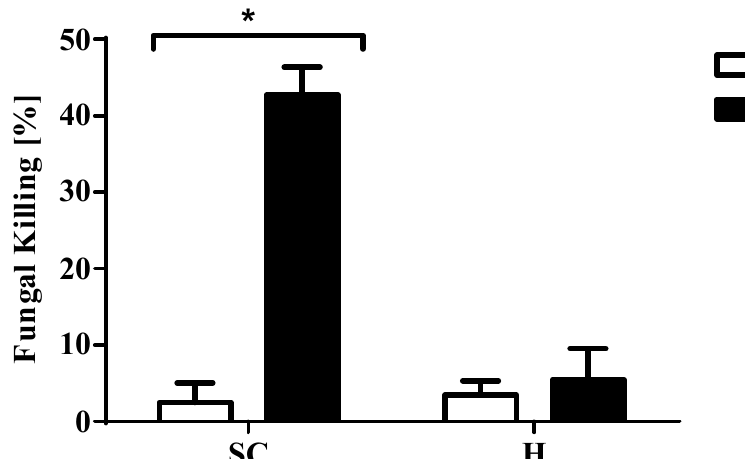
Figure 2. Killing activity of expanded NK cells as determined by XTT assay. The killing effect of expanded NK cells and PBMC on the two morphotypes of A. fumigatus , namely, SC—swollen conidia and H—hyphae was determined. The Effector: Target (NK cell: Aspergillus or PBMC: Aspergillus ) ratio used was 2:1. Data represent the mean of duplicate measurements (± SEM) pooled from 5 experiments. * p < 0.05 compared to PBMC.